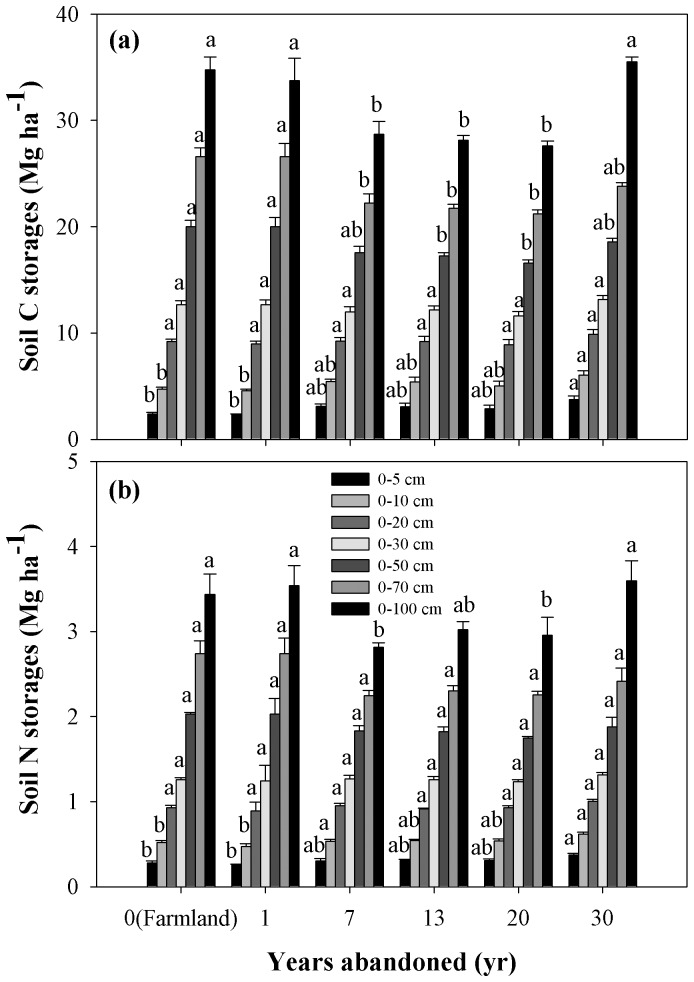
Dynamics of soil OC and N storages in 0–100 cm soil depth following the conversion of farmland to grassland.Values are in the form of Mean ± SE and the sample size n = 5. Different lower-case letters above the bars mean significant differences in the same soil layers among abandoned land in different years (P<0.05).